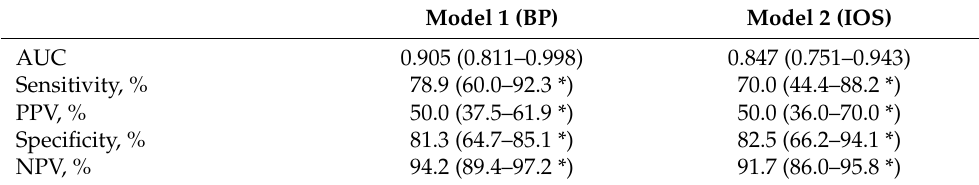
Table A2. Diagnostic accuracy of the logistic regression models when all 100 patients were included.